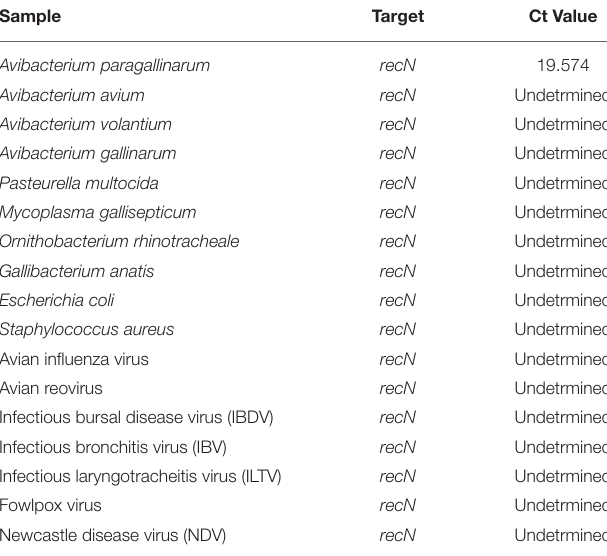
TABLE 1 | Analytical specificity and sensitivity of recN based